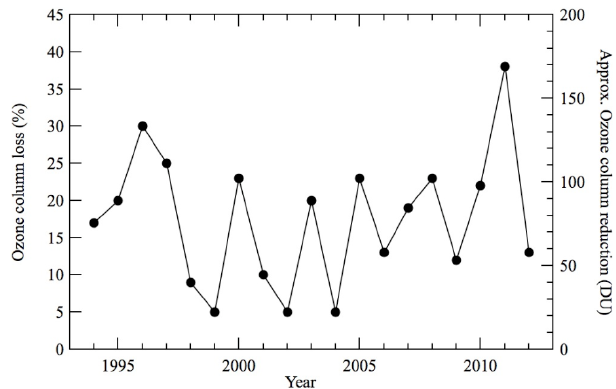
Fig. 7. Yearly ozone loss in the Arctic since 1994 derived from the measurements of the SAOZ/NDACC stations by the passive ozone method revisited using ERA-Interim